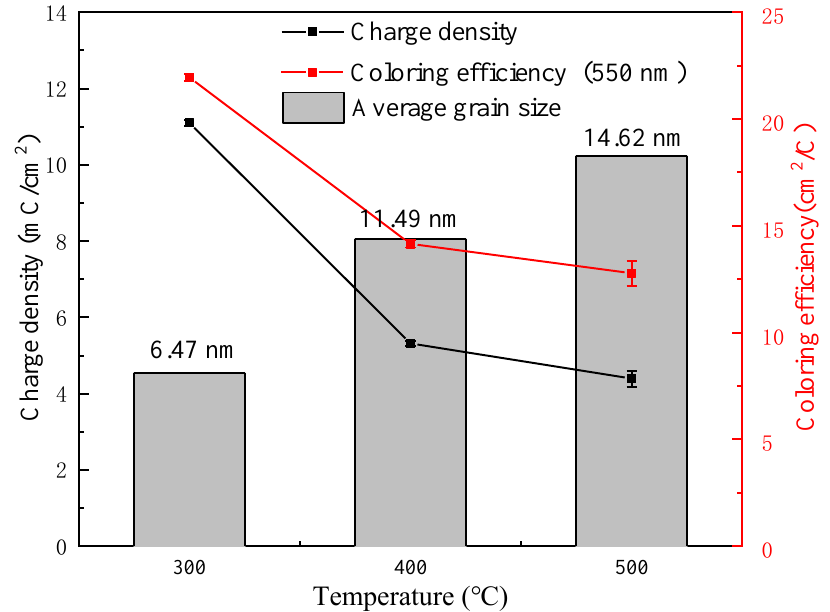
Figure 8. Trends in crystallite size, charge density, and coloring efficiency of NiO films with different annealing temperatures.